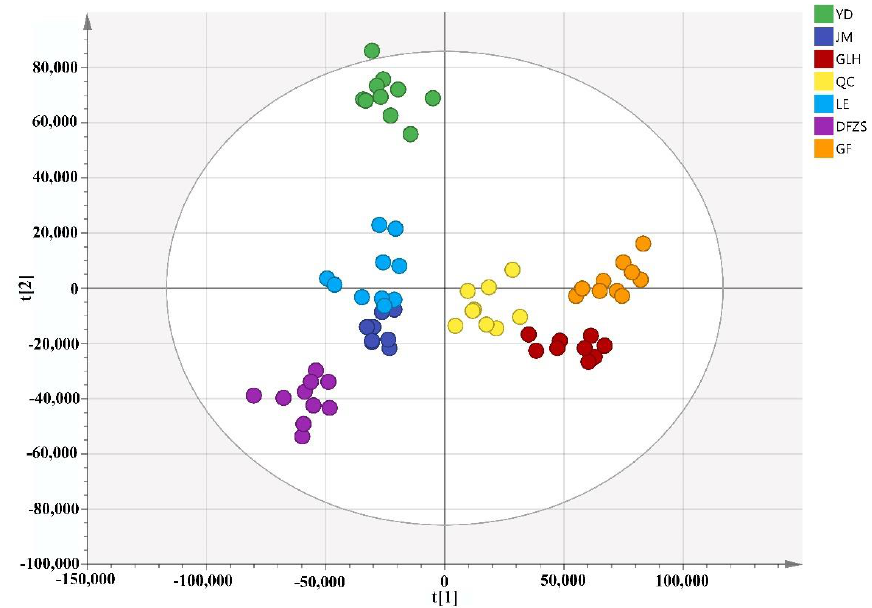
Figure 1. PCA score plot of volatile compounds of six varieties of P. mume blossom samples.